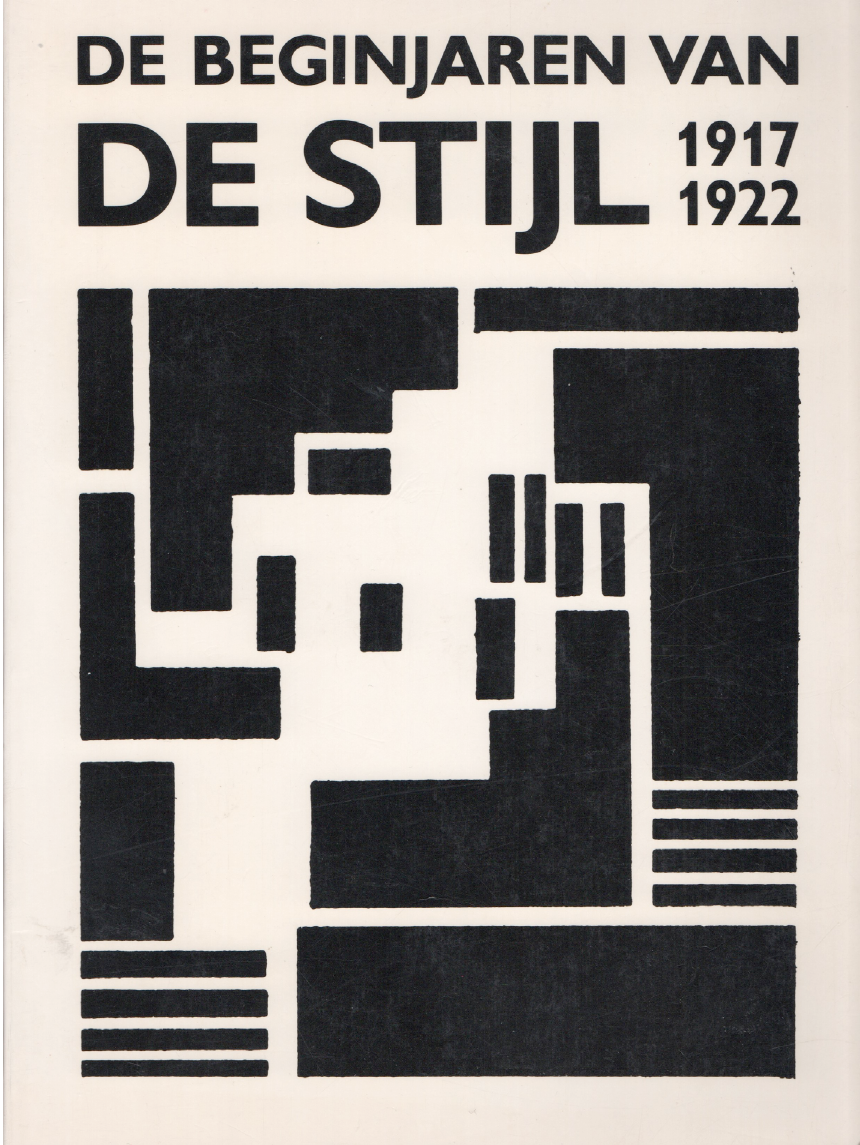
Fig. 3 Front cover of the book De Beginjaren van de Stijl 1917-1922 by Carel Blotkamp, 1982. Photo by Rixt